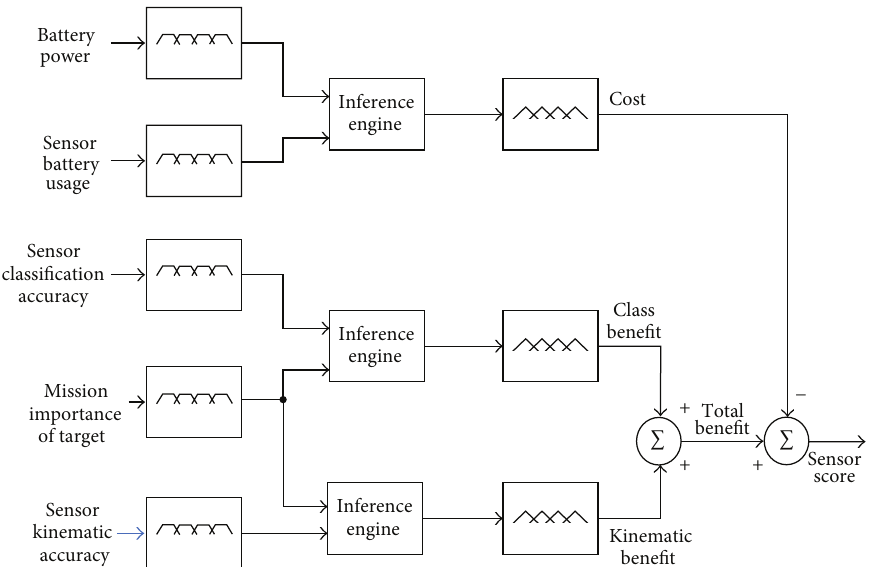
Figure 5: Fuzzy resource allocation technique for target tracking and classification.